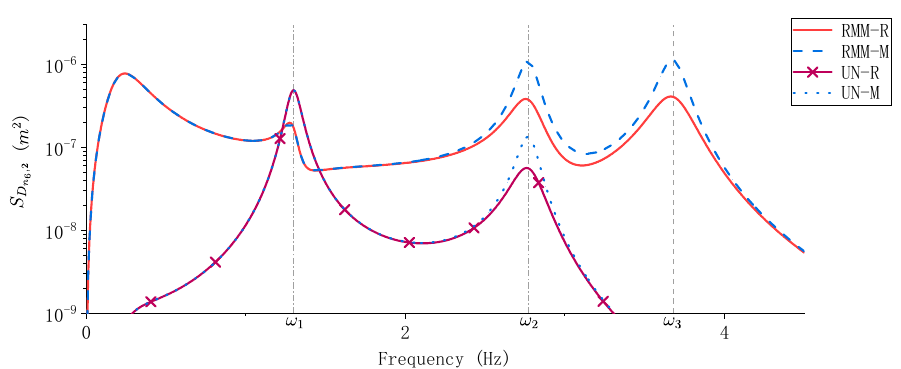
ff erent modeling methods are used. when different modeling methods are used. Figure 12. Comparison of the PSD of D n 6 ,2 when di (cid:3122) ,(cid:2870)